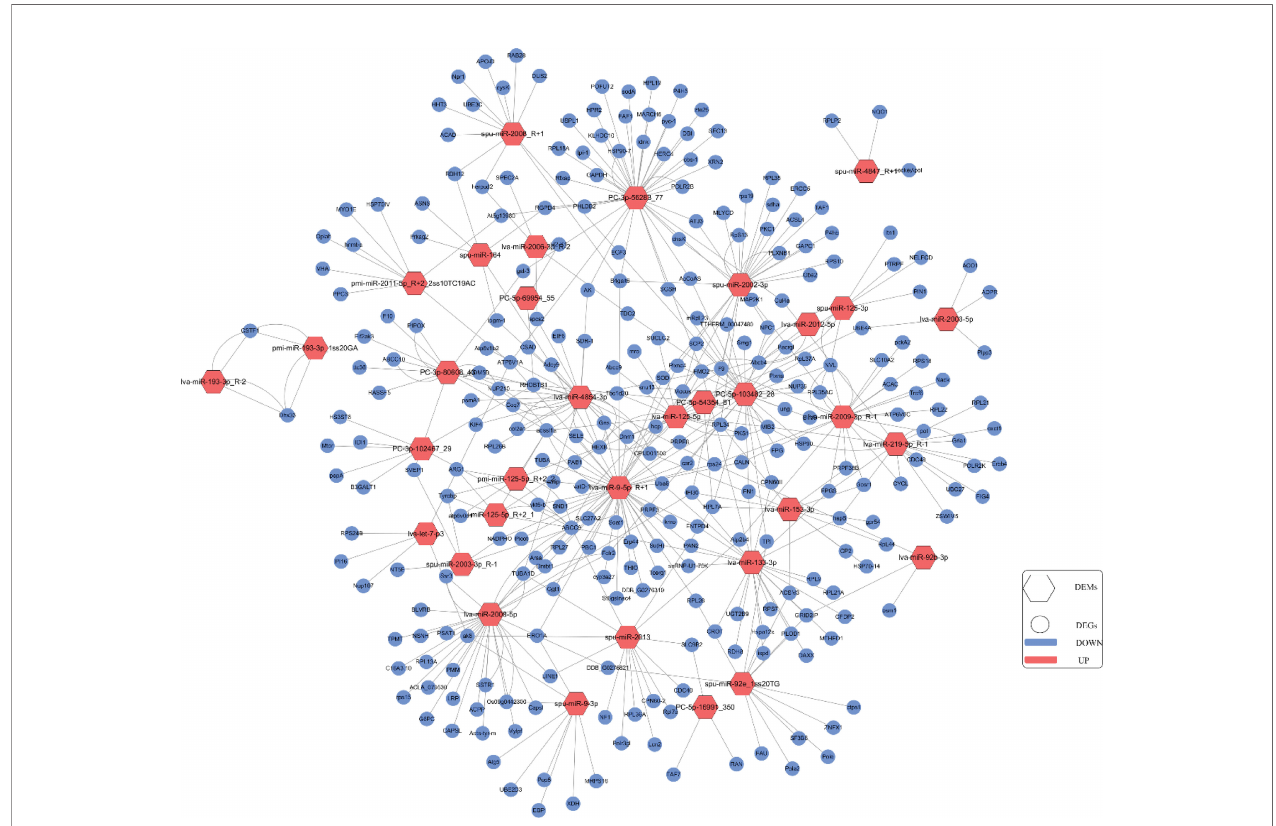
FIGURE 6 | The network of DEMs and their target DEGs was constructed using Cytoscape 3.3.0. Hexagon is miRNA, circle is target DEGs, red means up- regulated expression, blue means down-regulated